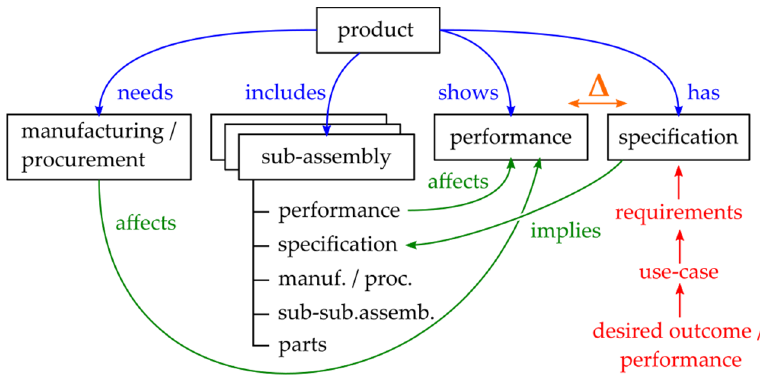
Figure 4. Generic breakdown structure of the type of system investigated.